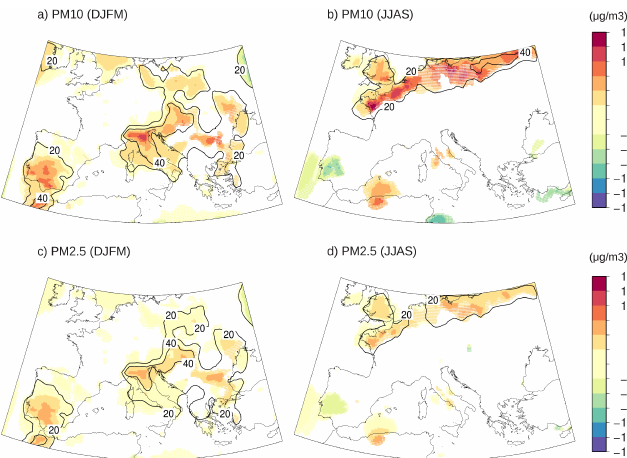
Fig. 8. As in Fig. 5, here for particulate matter: (a, b) PM 10 and (c, d) PM 2 . 5